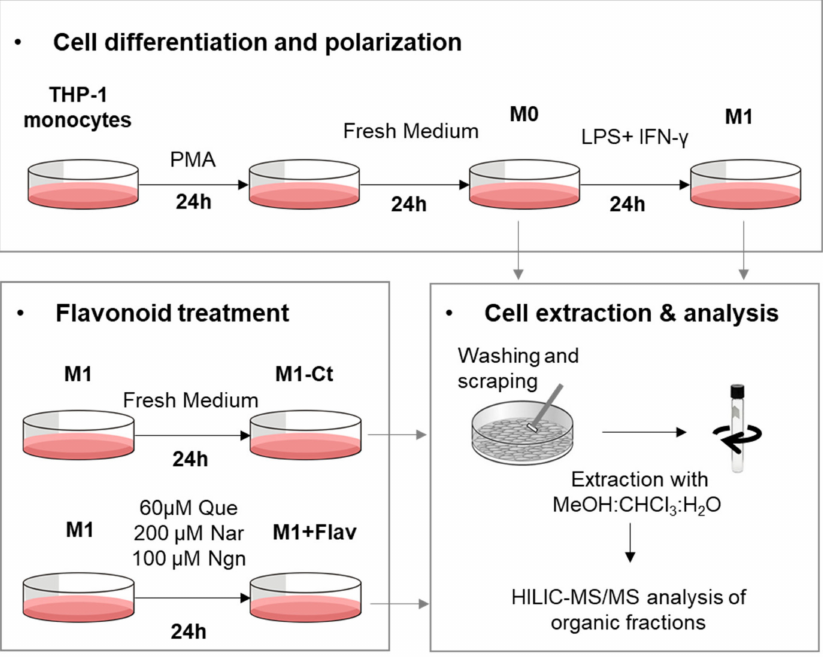
Figure 1. Schematic representation of cell culture and sample collection for HILIC-MS / MS analysis (Flav, flavonoid; Que, quercetin; Nar, naringin; Ngn,